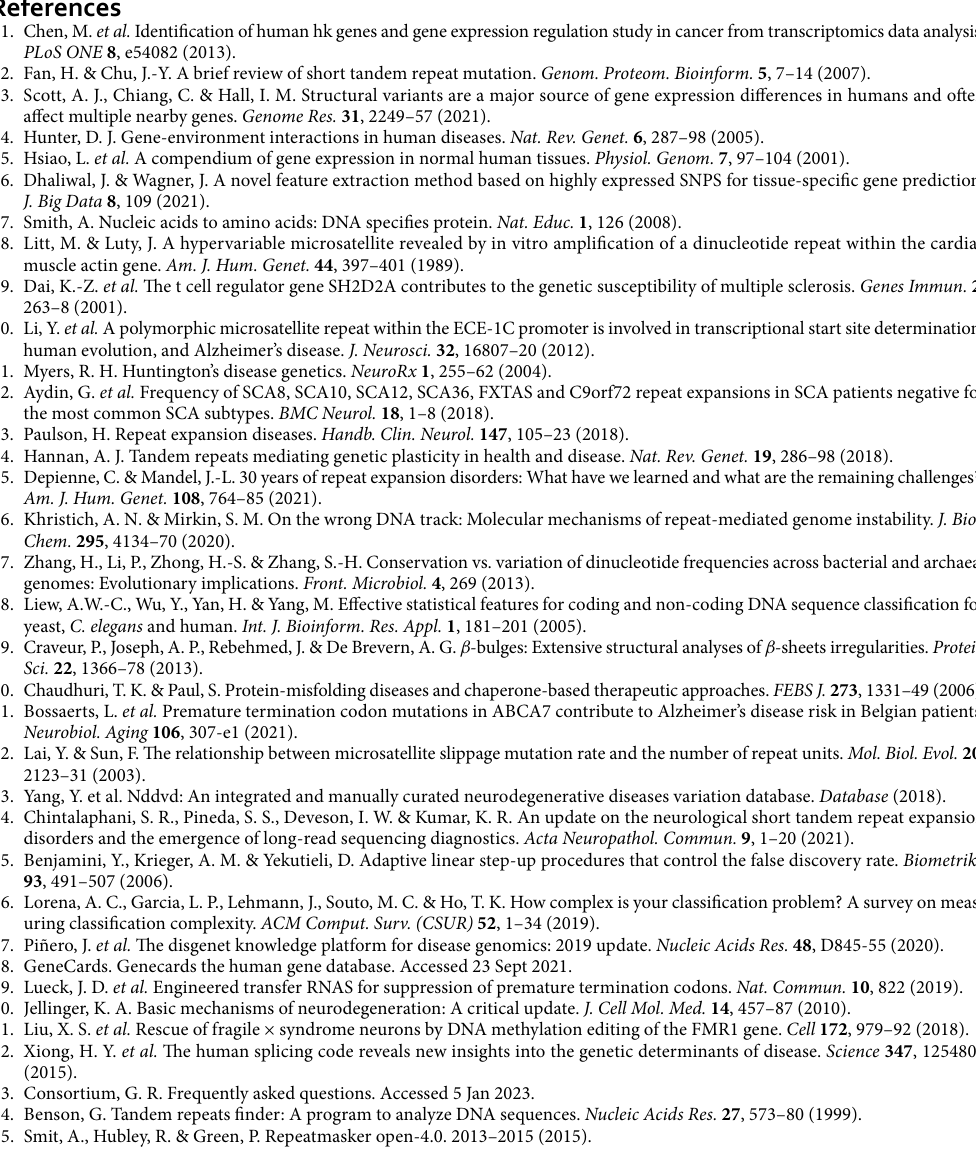
table_ type= genes & key= dba8ff ad2c 6f0a5 f95dd 05d62 e129c